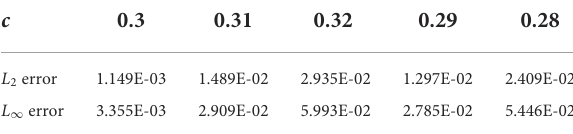
TABLE 1 Errors of the CANN simulation for Example 3.1 at T = 0.25 with different c